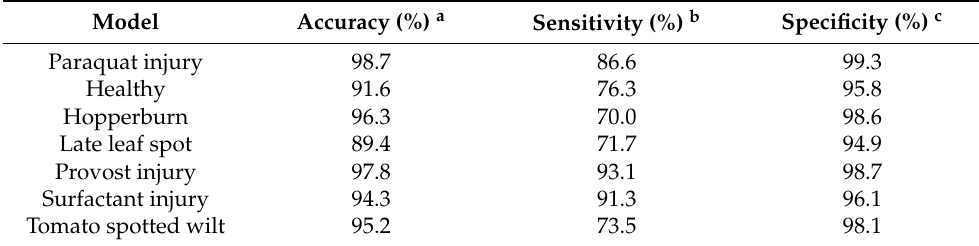
Table 2. Performance of paraquat injury, healthy, hopperburn, late leaf spot, Provost injury, surfactant injury, and tomato spotted wilt diagnostic